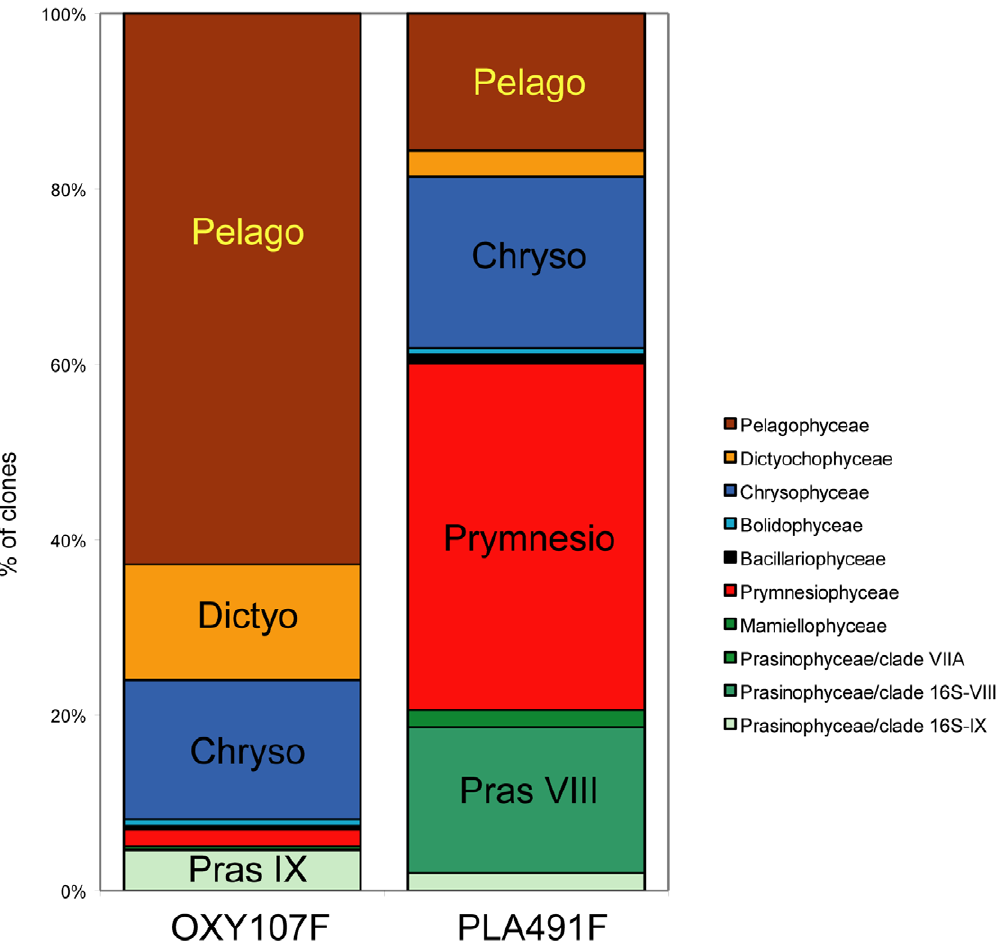
Figure 5. Overall composition of plastid 16S rRNA gene clone libraries constructed with two primer sets. Primer sets: OXY107F/ OXY1313R and PLA491F/OXY1313R. Composition is expressed as percent of clones. Only samples for which both primers were used are included.